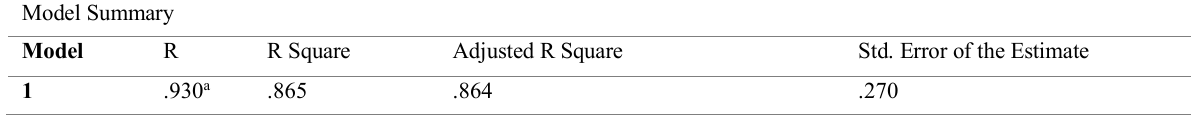
Table 9: Regression model summary for participative leadership